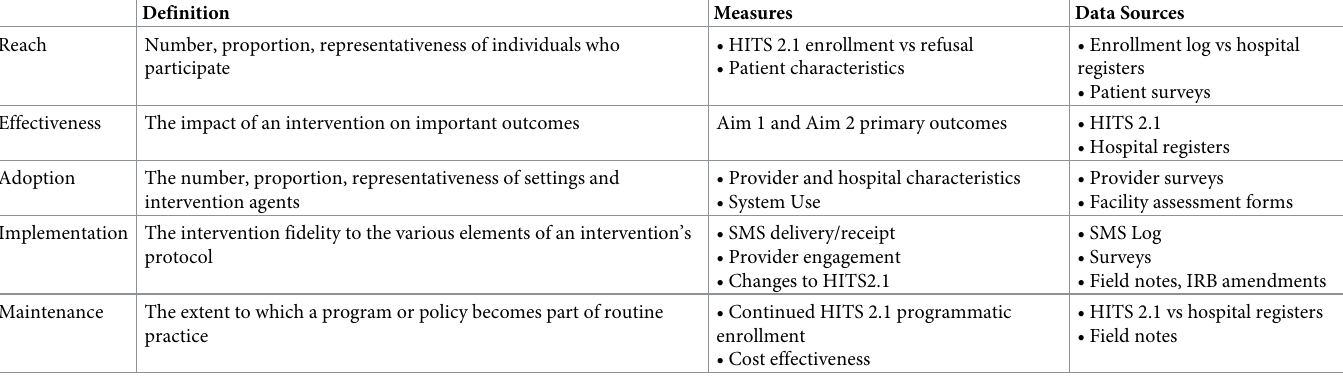
Table 3. HITSystem 2.1 implementation evaluation guided by the RE-AIM